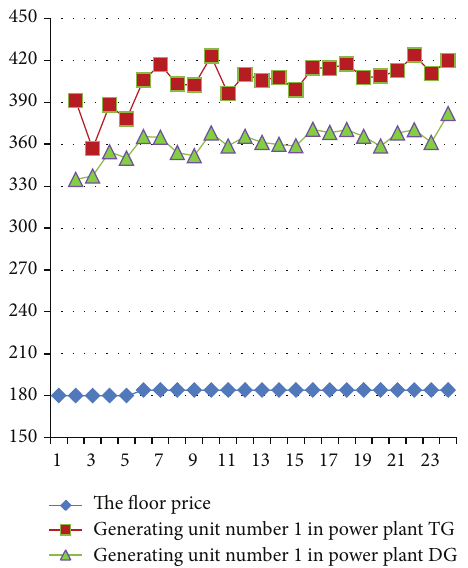
Figure 6: The relationship between floor price and producer’s bidding strategy.